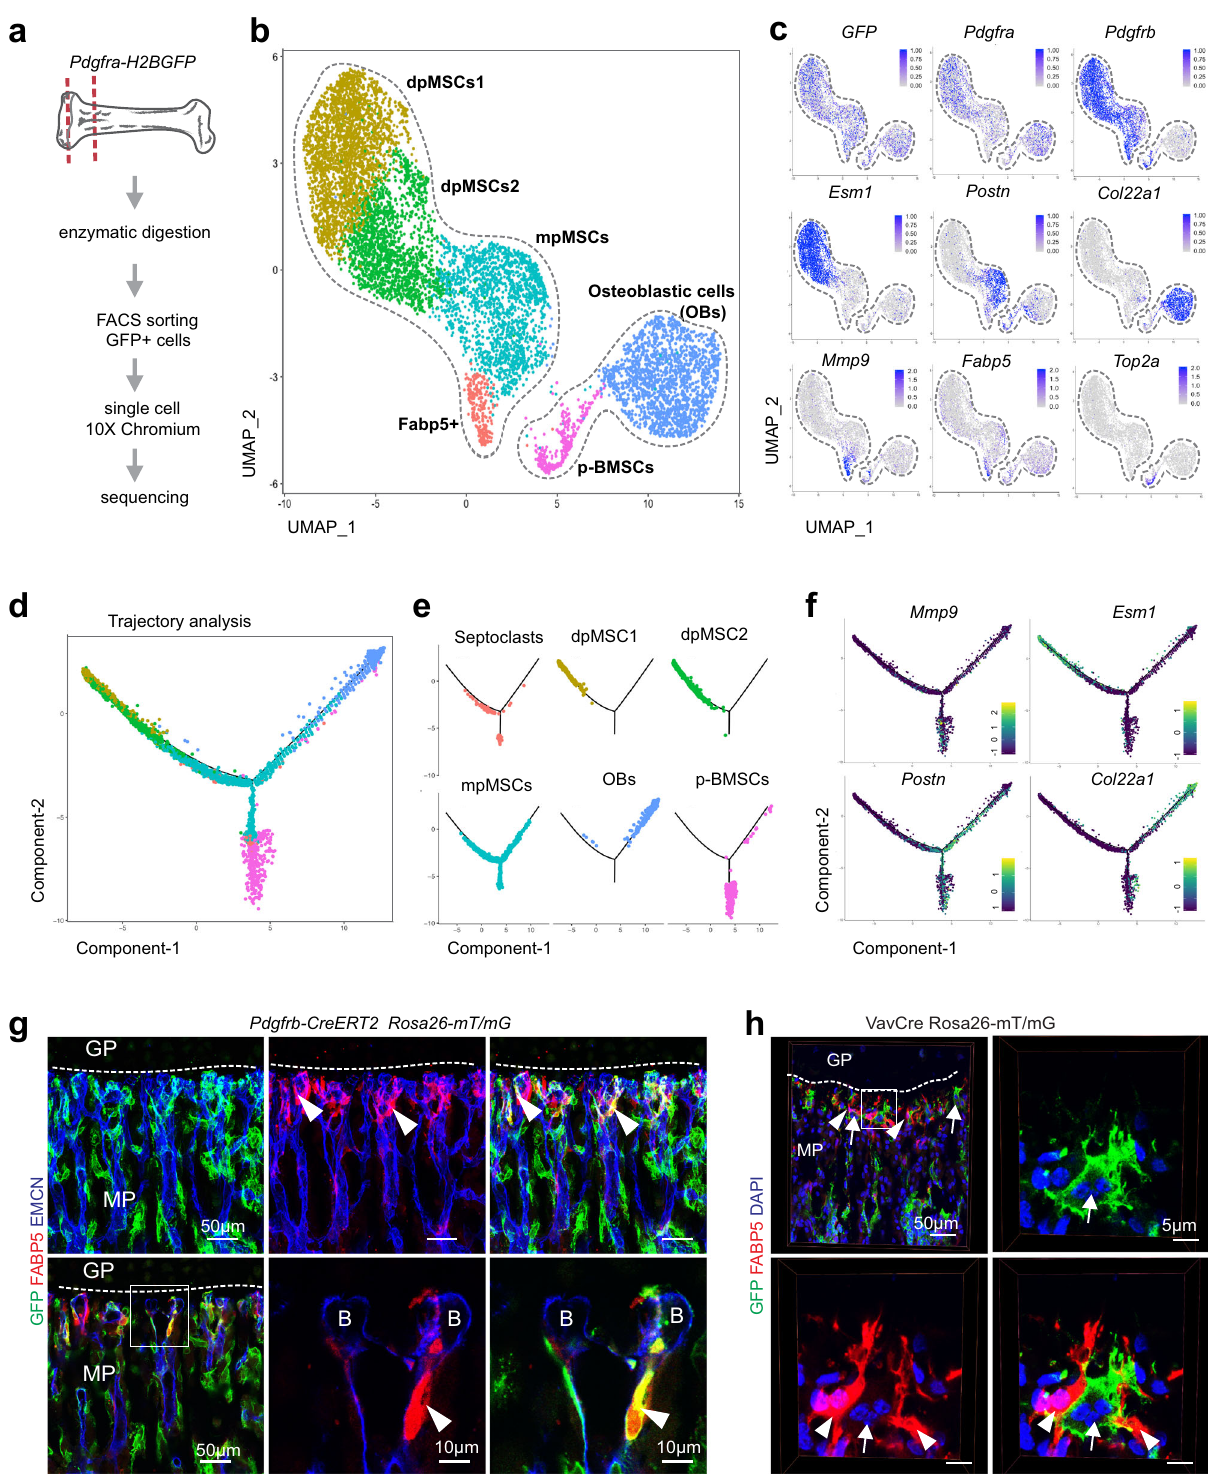
Fig. 2 Molecular signature and differentiation of SCs. a Preparation of 3-week-old Pdgfra-GFP metaphysis-epiphysis region from femur and tibia for scRNA-seq analysis. b , c scRNA-seq of 3-week-old Pdgfra-H2BGFP reporter bone. UMAP plot of colour-coded cell clusters within Pdgfra-GFP + positive cells ( b ) and visualization of cell type-speci fi c marker genes ( c ). d – f Monocle trajectory analysis of BMSC lineage differentiation with coloured cell clusters ( d ) and representation of individual cluster in trajectory ( e ). Cell type-speci fi c relative gene expression shown in pseudo-time ( f ). g , h Representative confocal images of 3-week-old Pdgfrb-CreERT2 R26-mT/mG reporter femur with GFP + (green) and FABP5 + (red) SCs (arrowheads) near vessel buds (B). Bottom panels show a single optical plane (left) and higher magni fi cations of the boxed area (centre and right), respectively ( g ). Vav1-Cre -controlled R26-mT/mG reporter activation (GFP expression) labelling hematopoietic cells and osteoclasts (arrow) but not FABP5 + (red) SCs (arrowheads) ( h ). Independent animals, g, h ( n =